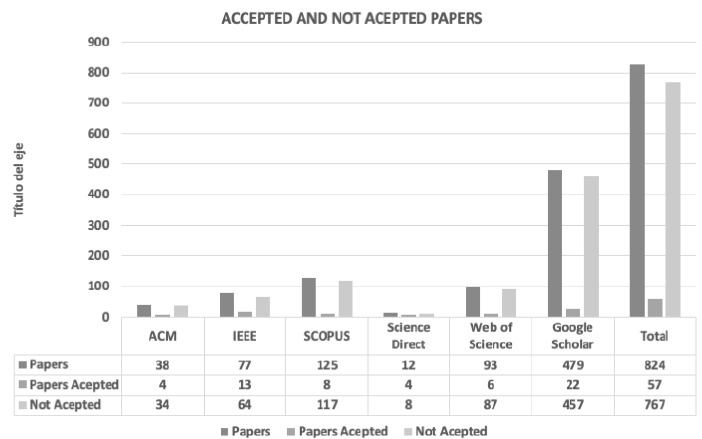
Figure 2. Accepted and rejected papers, second systematic revision